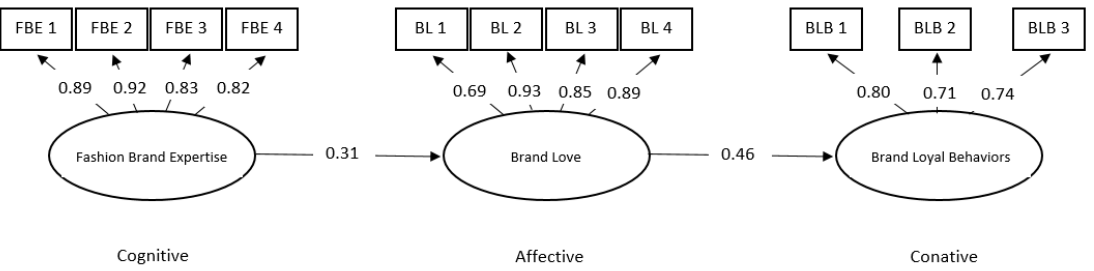
Figure 1. Summary of SEM results.